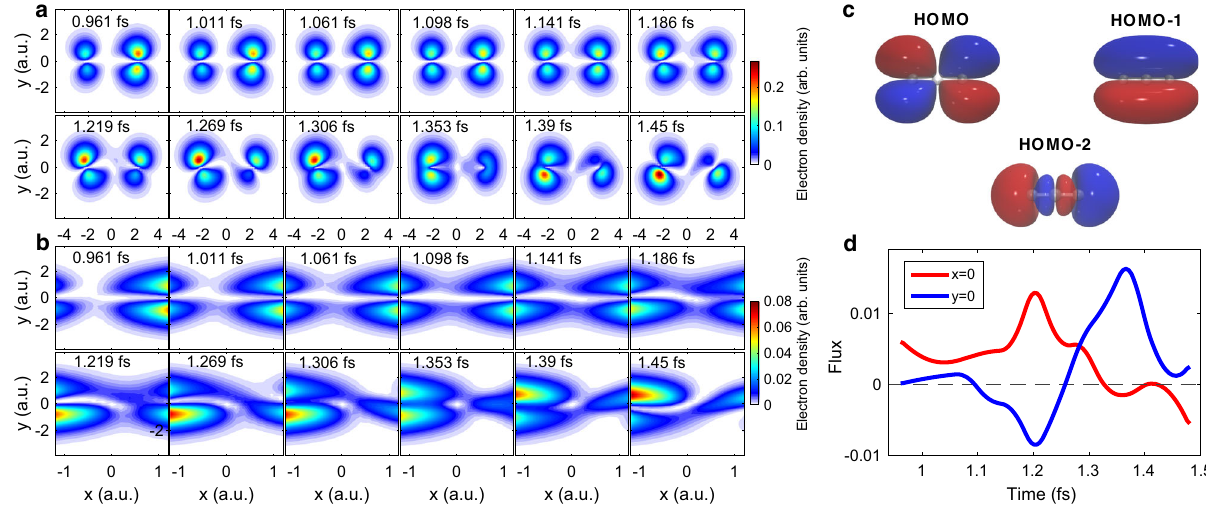
Fig. 3 | Reconstruction of attosecond charge migration in CO + 2 . a Snapshots of the reconstructed hole densitiesfor the alignment angle of0°. b Enlarged views of theresultsin( a )intherangefrom x = − 1.2a.u.to x =1.2a.u. c HOMO,HOMO-1,and